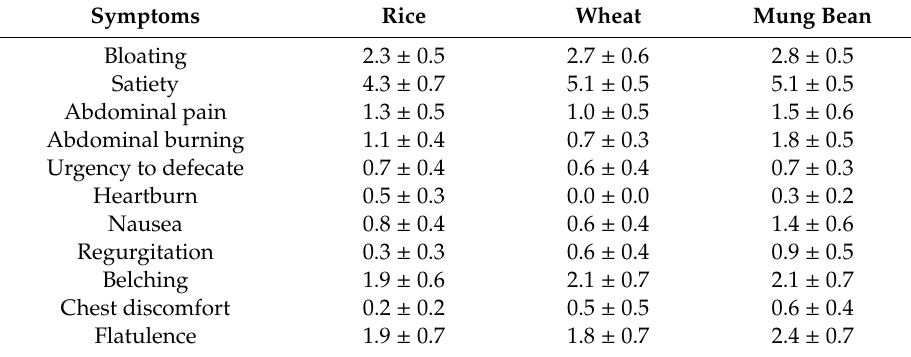
Table 1. Baseline gastrointestinal symptom scores before breakfast for rice, wheat, and mung bean study arm (data expressed as mean ± SEM)